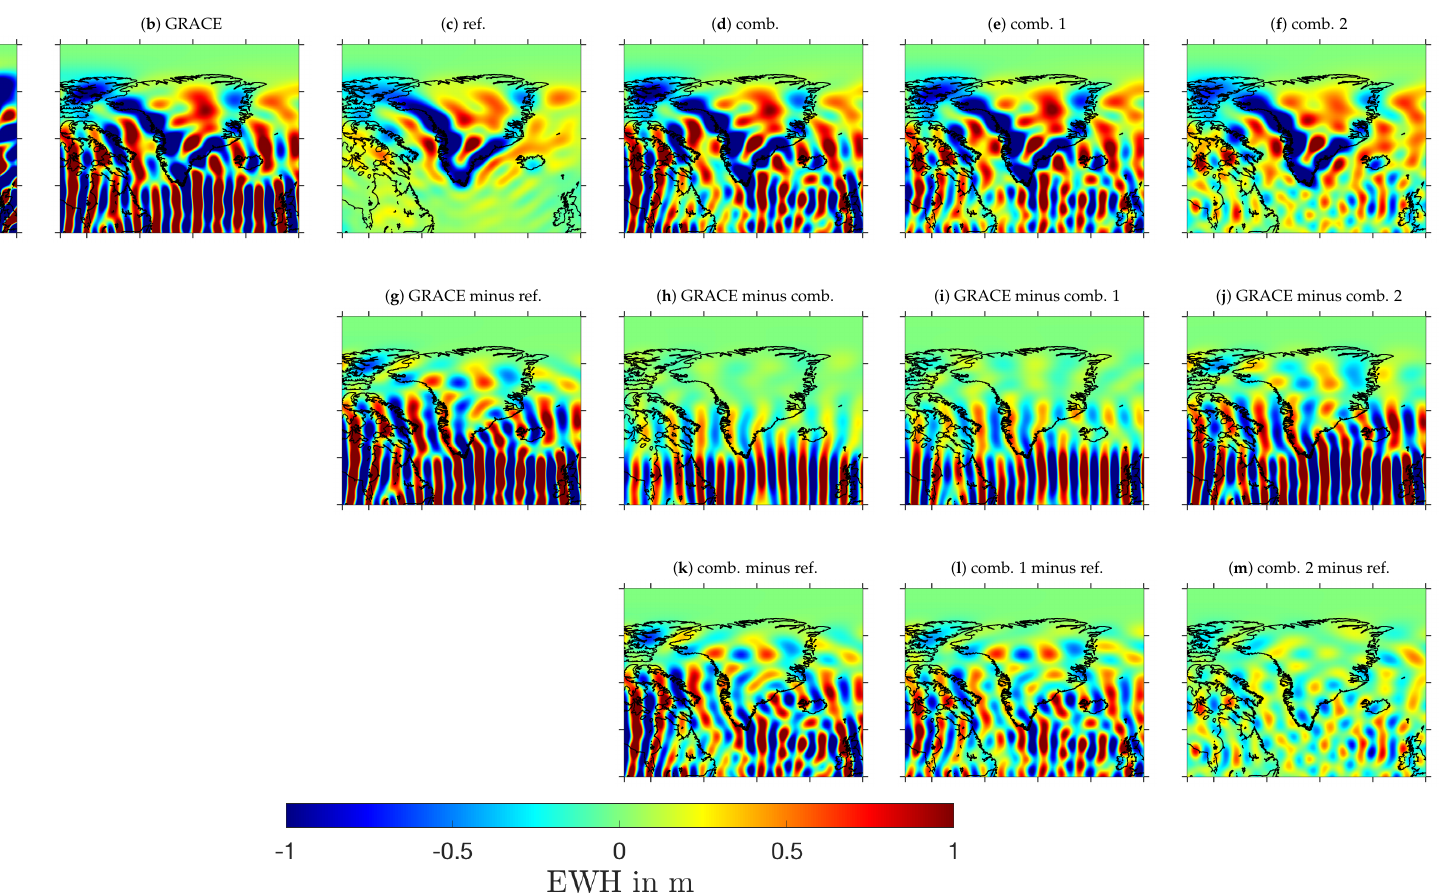
Figure 15. Monthly d/o 96 SH gravity field solutions for September 2011, evaluated as EWH grids in the region around Greenland. The x-axis denotes the longitude λ , with values from 270 ◦ to 360 ◦ , and the y-axis denotes the colatitude θ , with values from 0 ◦ to 40 ◦ . Panels ( a – f ) show the differences of individual models to the static and trend part of the GOCO06s model [9], evaluated on 1st January 2005. The individual model names are explained in Section 3.3.2. Panels ( g – j ) show the difference of the GRACE model ( b ) to the models ( c – f ). The panels ( k – m ) show the difference of the combination models ( d – f ) to the reference model ( c ). In all panels, only non-polar gap wedge SH coefficients of degrees 10 to 96 have been